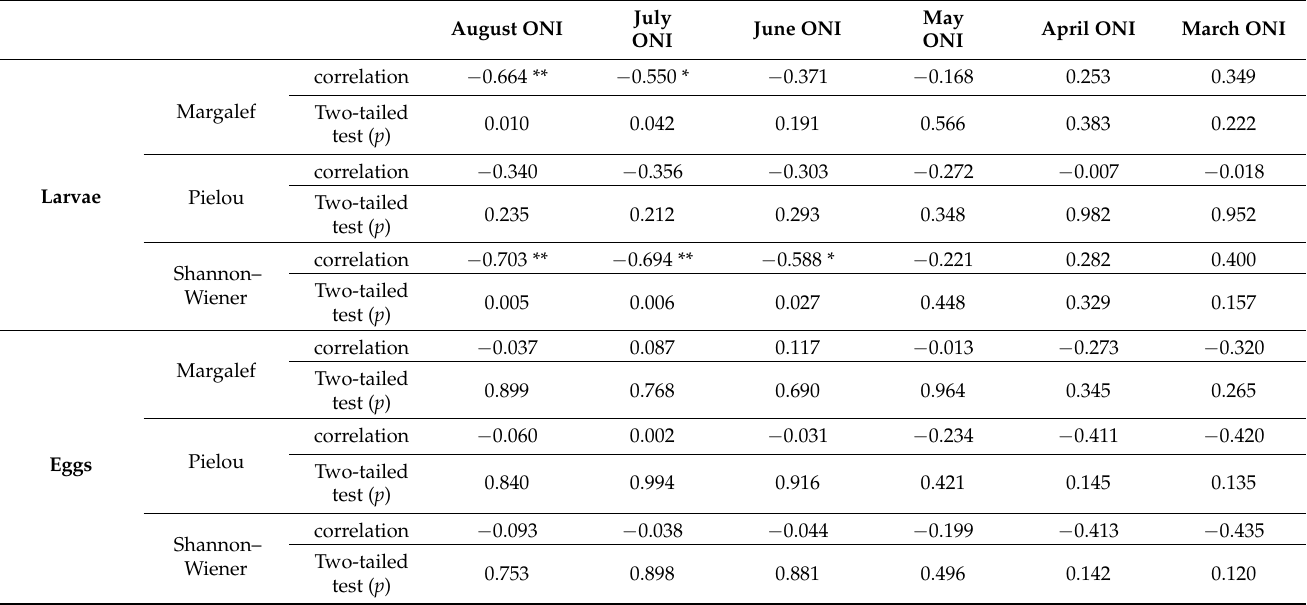
Table 2. Correlations between the taxonomic diversity and monthly ONI (** means p < 0.01, * means p <